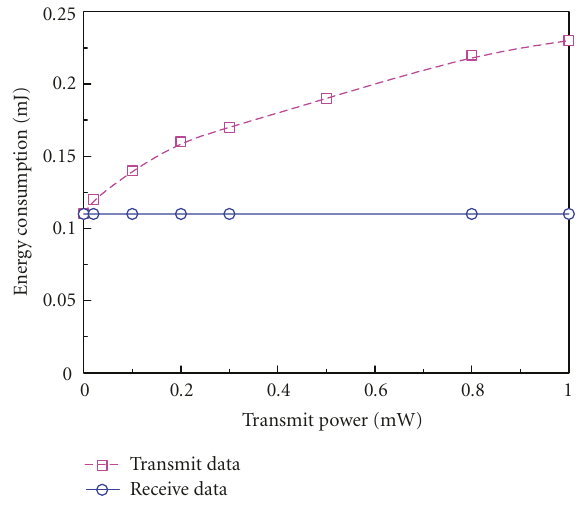
Figure 3: Energy consumption with di ff erent transmit power.